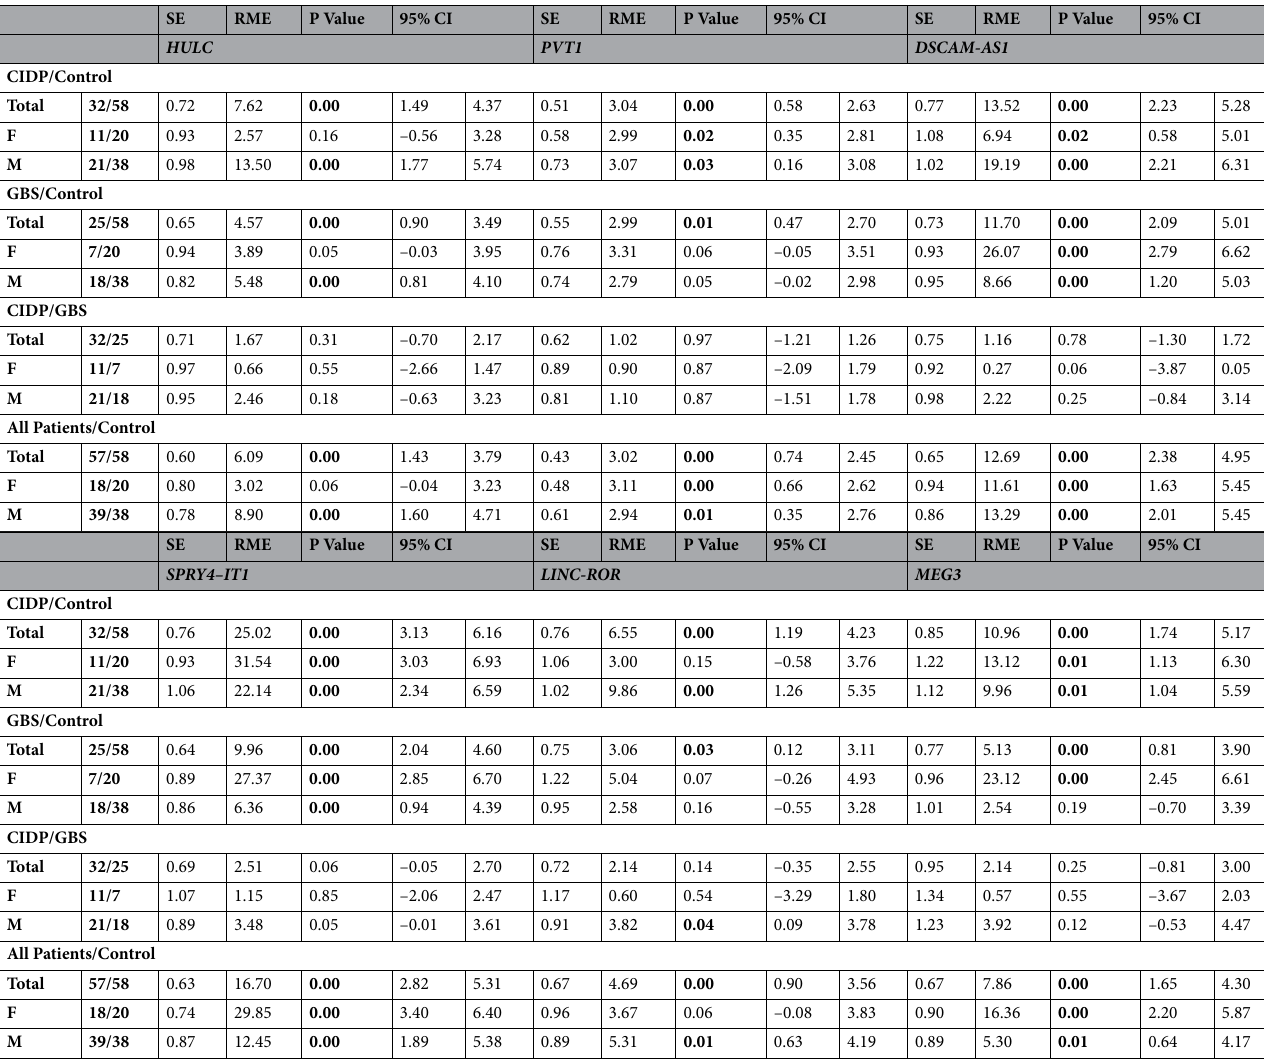
Table 3. Detailed parameters of expression analysis of lncRNAs in patients and